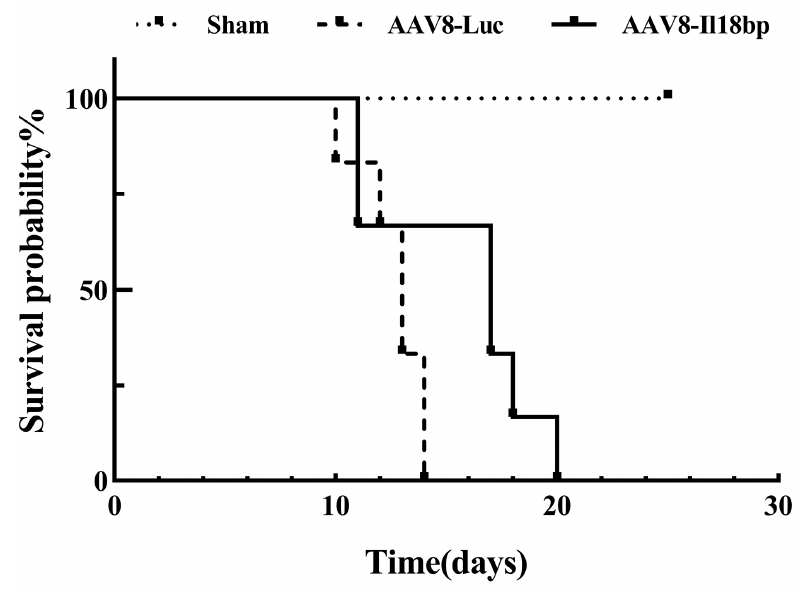
Figure 7. High levels of IL-18BP prolonged survival time of the recipients after OLTx. Recipients whose donors were pretreated with AAV8-Il18bp had significantly prolonged survival compared with those whose donors were given AAV8-Luc. ( n = 6 in each group, median survival time (MST): 13 vs. 17 d); p < 0.01.